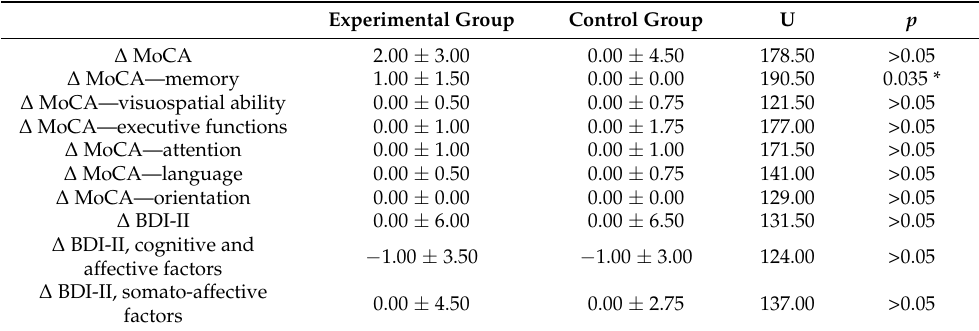
Table 3. Variations of MoCa and BDI scores in each group, according to the formula ∆ score = T1 score − T0